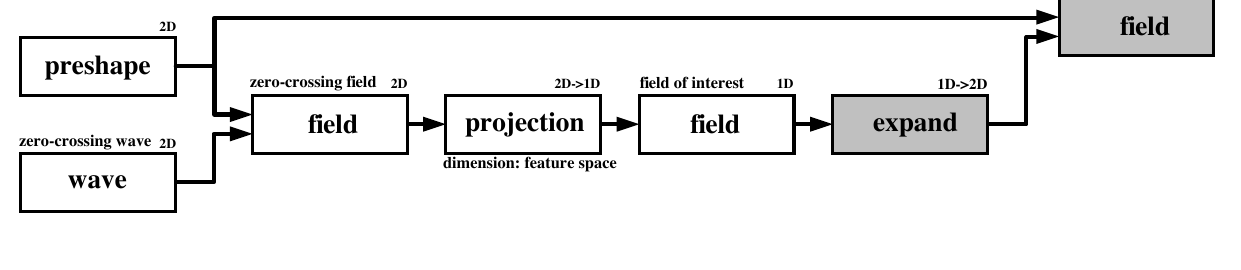
Figure 11. Detection of zero crossing using a normalized preshape and a gaussian wave